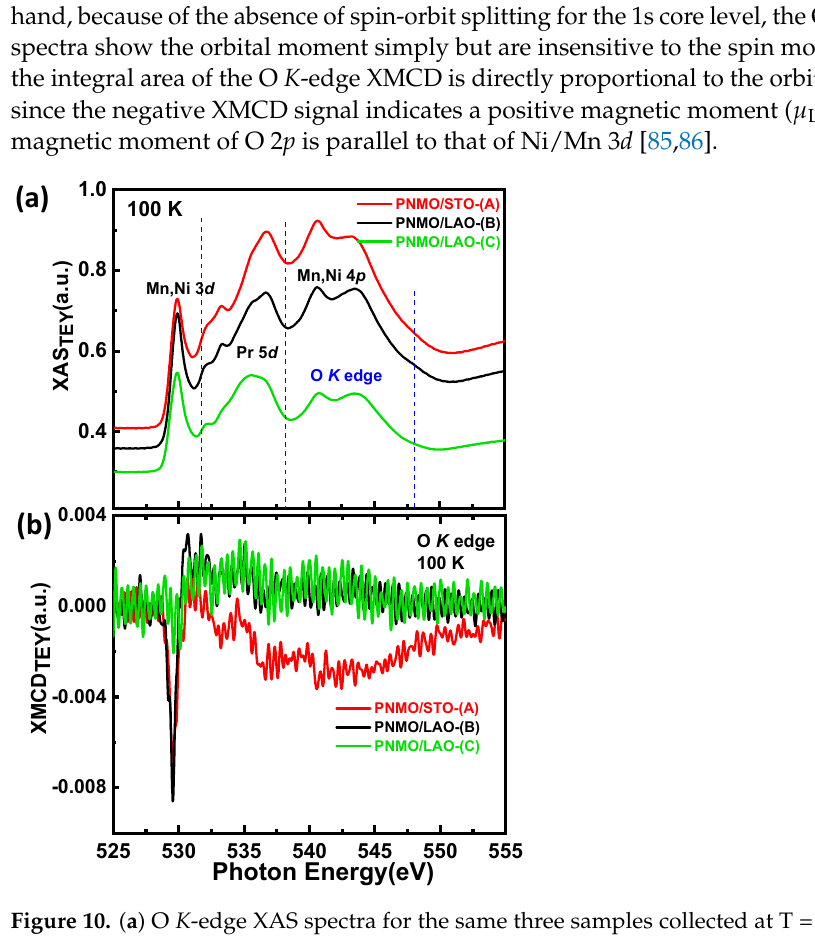
Figure 10. ( a ) O K -edge XAS spectra for the same three samples collected at T = 100 K. ( b ) XMCD data collected over O K -edge at T = 100 K under an applied field of 2 T.